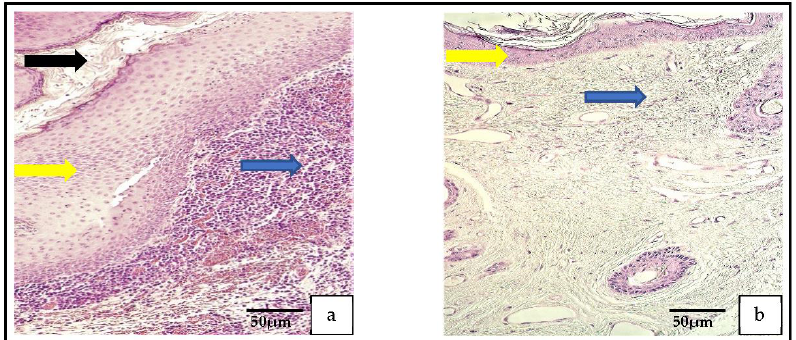
Figure 1. ( a ) Histological micrograph of cholesteatoma. The cholesteatoma matrix (yellow arrow) is the hyperproliferative stratified squamous epithelium. Perimatrix (blue arrow) consists mostly of inflammatory cells and the cystic layer (black arrow) consists of desquamated, anucleate keratin mass. Hematoxylin and eosin. ( b ) Histological micrograph of external ear skin demonstrates unchanged epithelium (yellow arrow) and subepithelial connective tissue (blue arrow) with hair follicles. Hematoxylin and eosin.